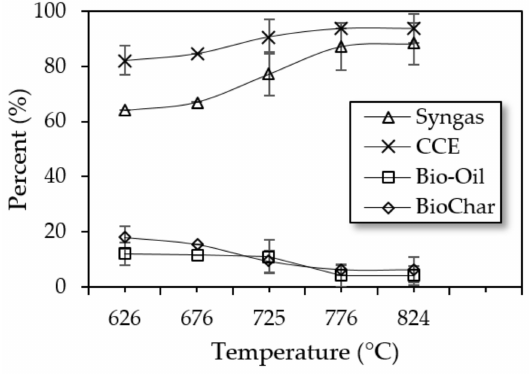
Figure 10. The e ff ect of temperature on gasification performance and e ffi ciency.